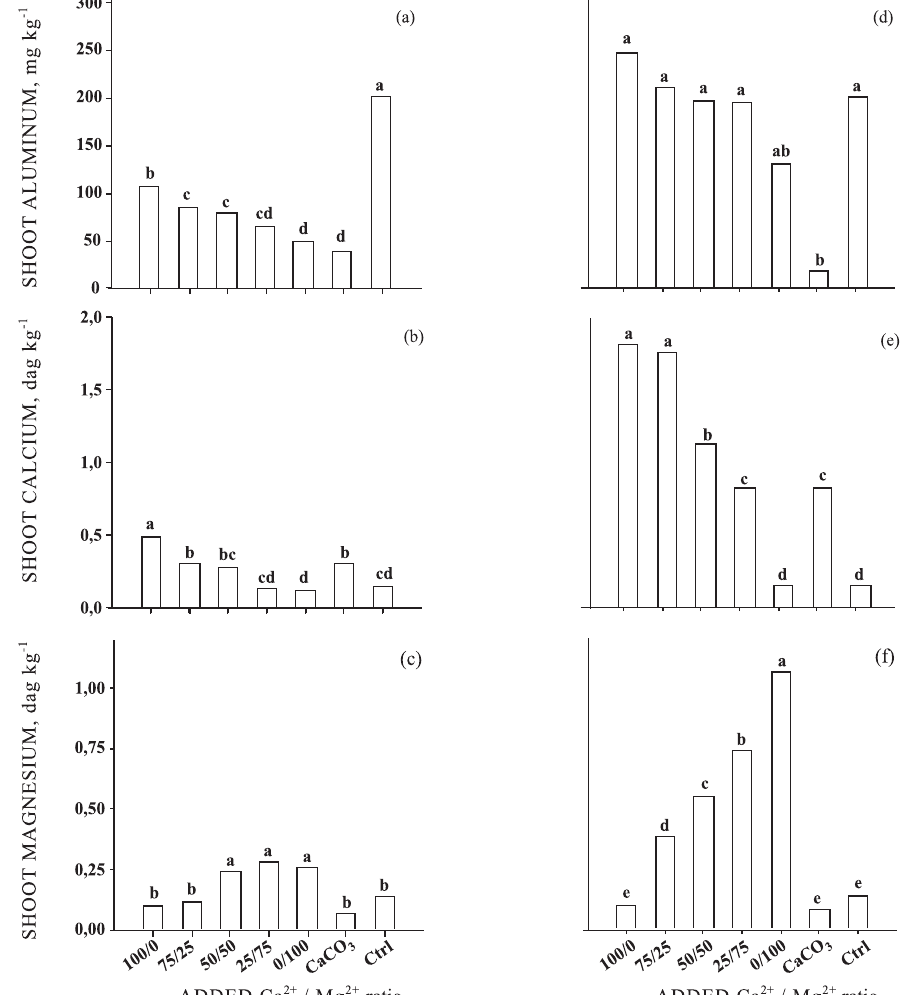
Figure 7. Shoot concentration of Al, Ca and Mg of soybean cv. UFVS-2001 grown in an acid soil with variable Ca:Mg ratios. A-C 10 % base saturation; D-F 60 % base saturation. Lime treatment received CaCO all other nutrients, except Mg. Control (Ctrl) treatment received no liming, but the supply of all other nutrients, except Ca and Mg, was ensured. Treatment means followed by the same letter are not significantly different by Tukey´s test ( ααααα =